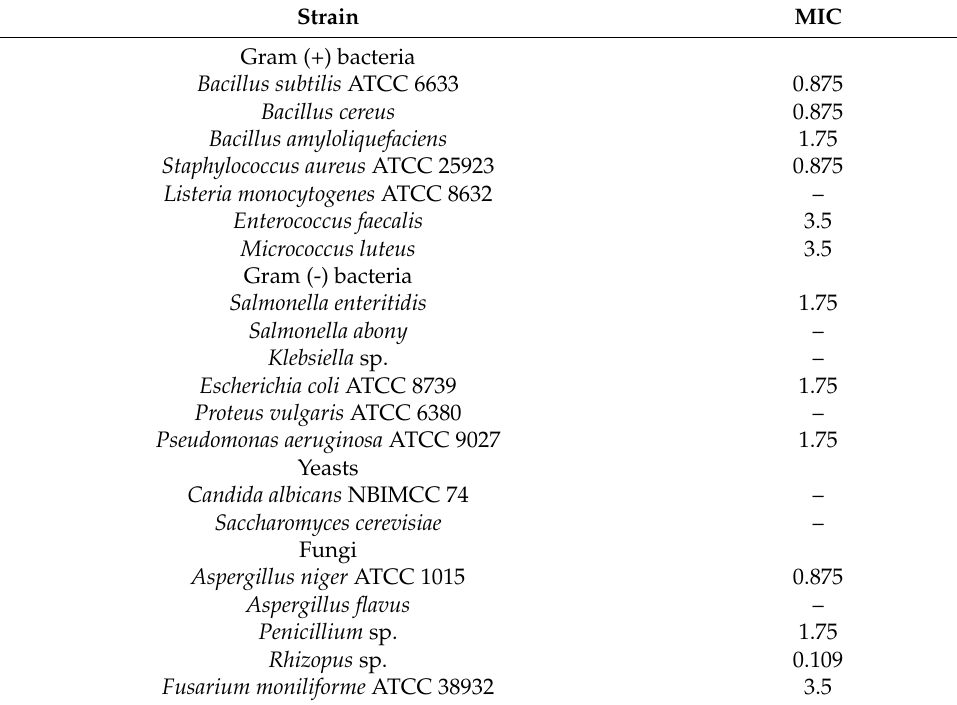
Table 5. Minimum inhibitory concentrations (MIC, mg/mL) of 70% methanol extract from Ginkgo biloba